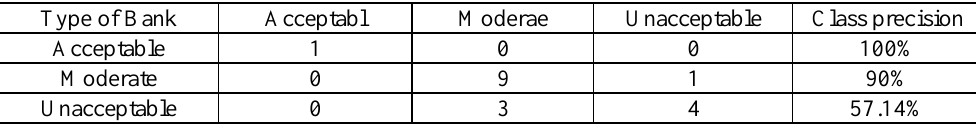
Table 2. C4.5 Decision Tree